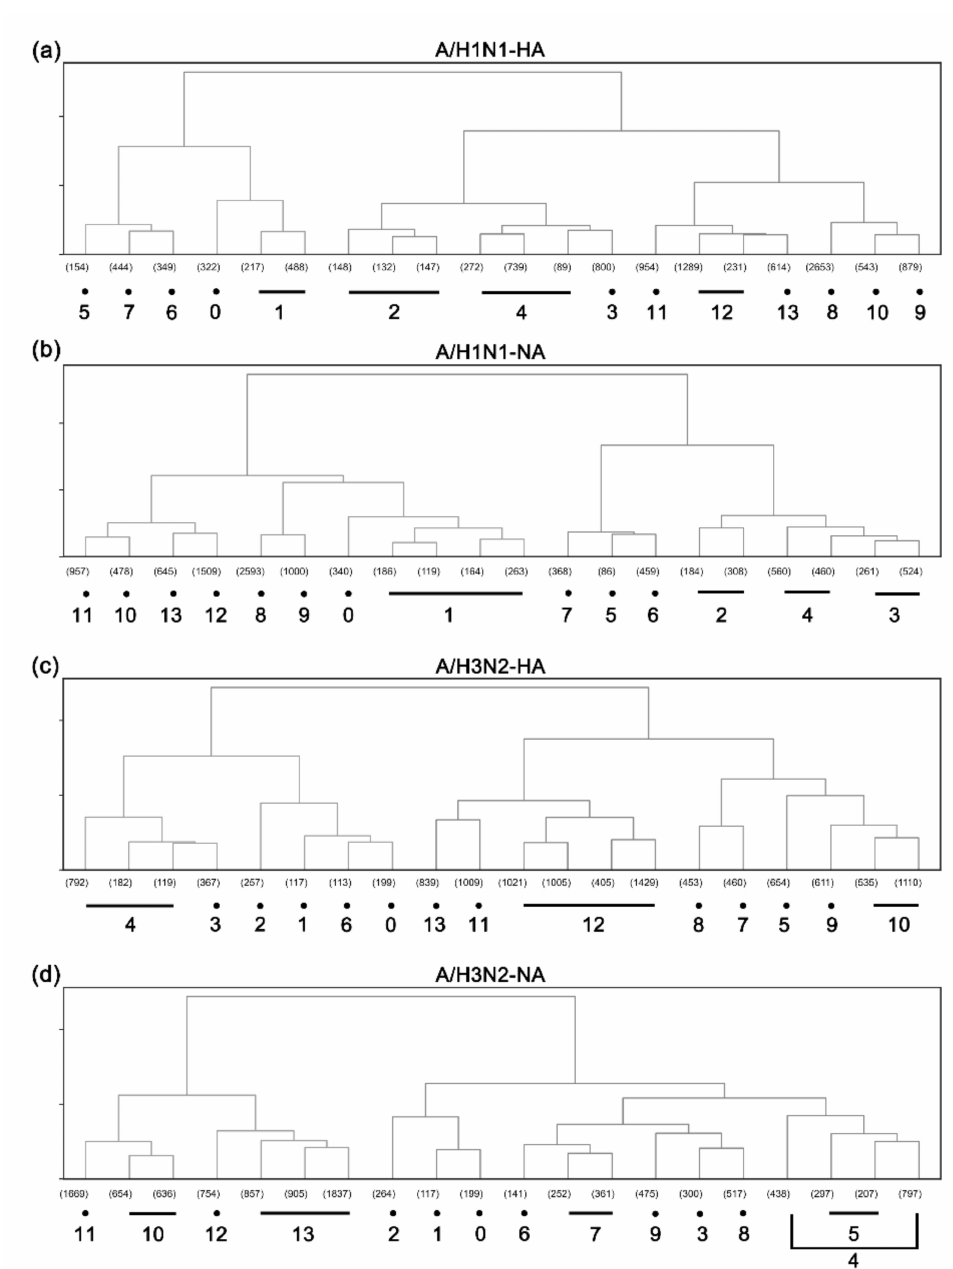
Figure 2. Hierarchical clustering analysis results. ( a ) A/H1N1-HA; ( b ) A/H1N1-NA; ( c ) A/H3N2- HA; ( d ) A/H3N2-NA. The number of virus strains in each initial cluster is indicated in brackets. Clusters are merged and reordered manually (as indicated at the